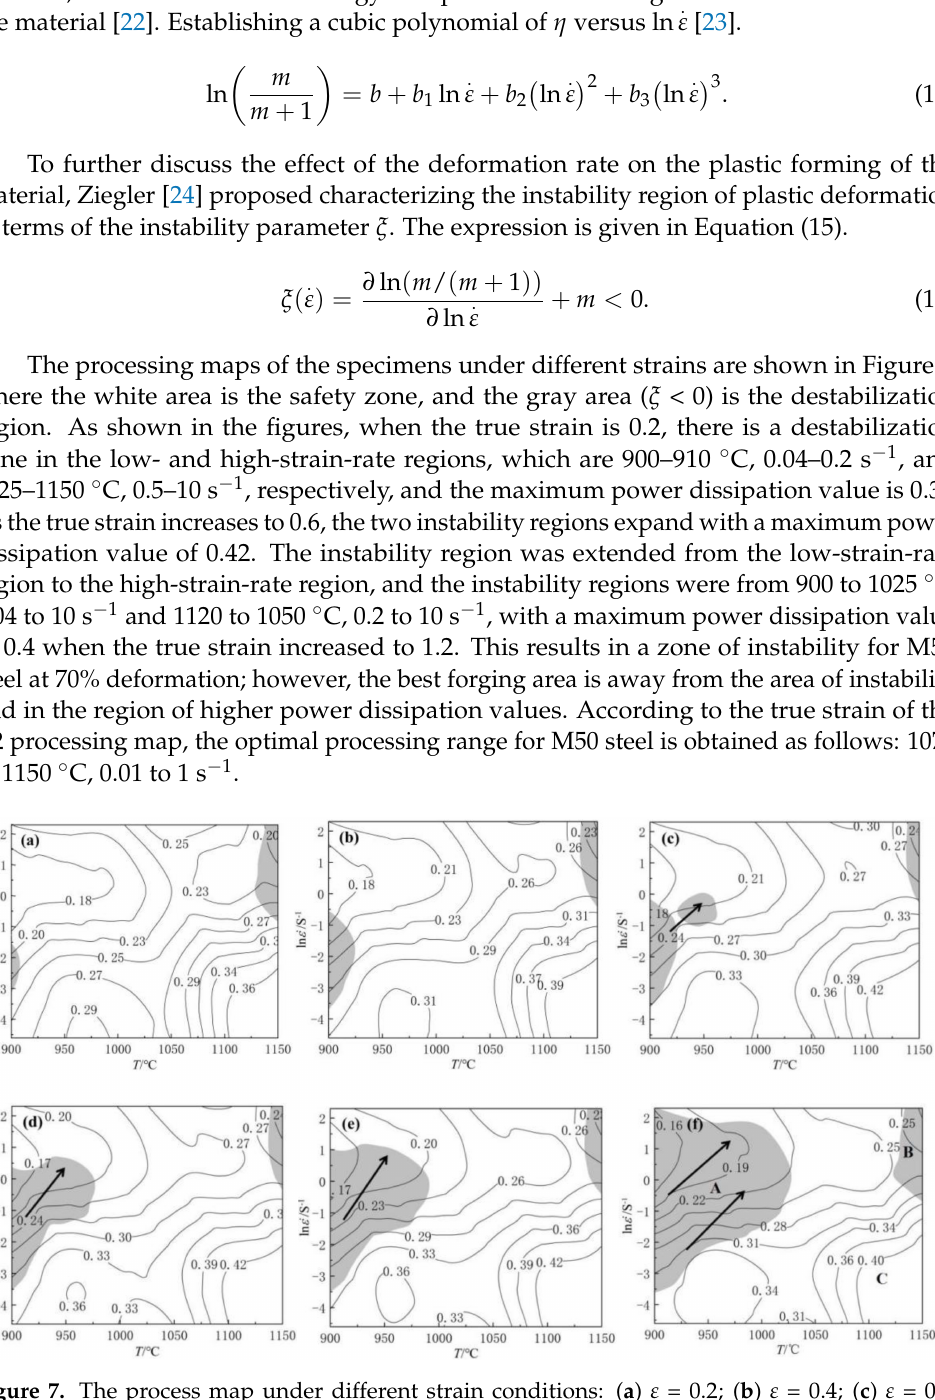
Figure 7. The process map under different strain conditions: ( a ) ε = 0.2; ( b ) ε = 0.4; ( c ) ε = 0.6; ( d ) ε = 0.8; ( e ) ε = 1.0; and ( f ) ε =